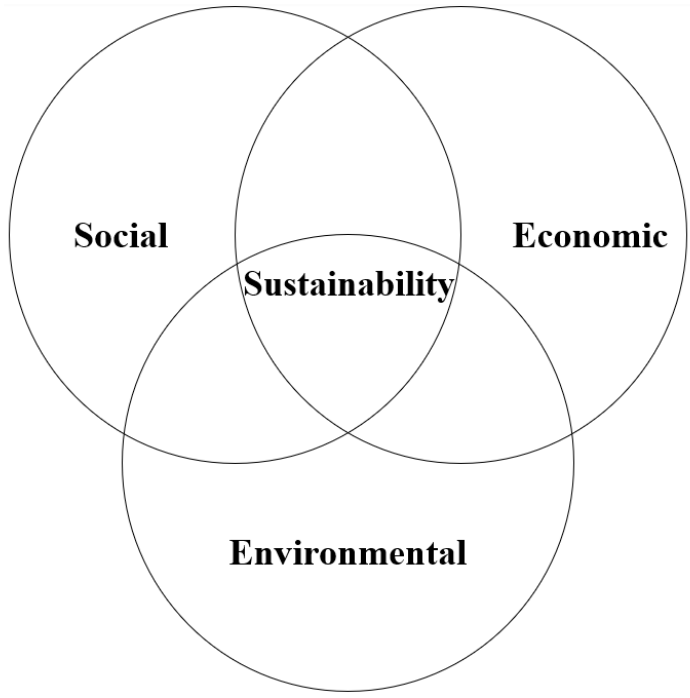
Figure 1. Sustainability Dimensions